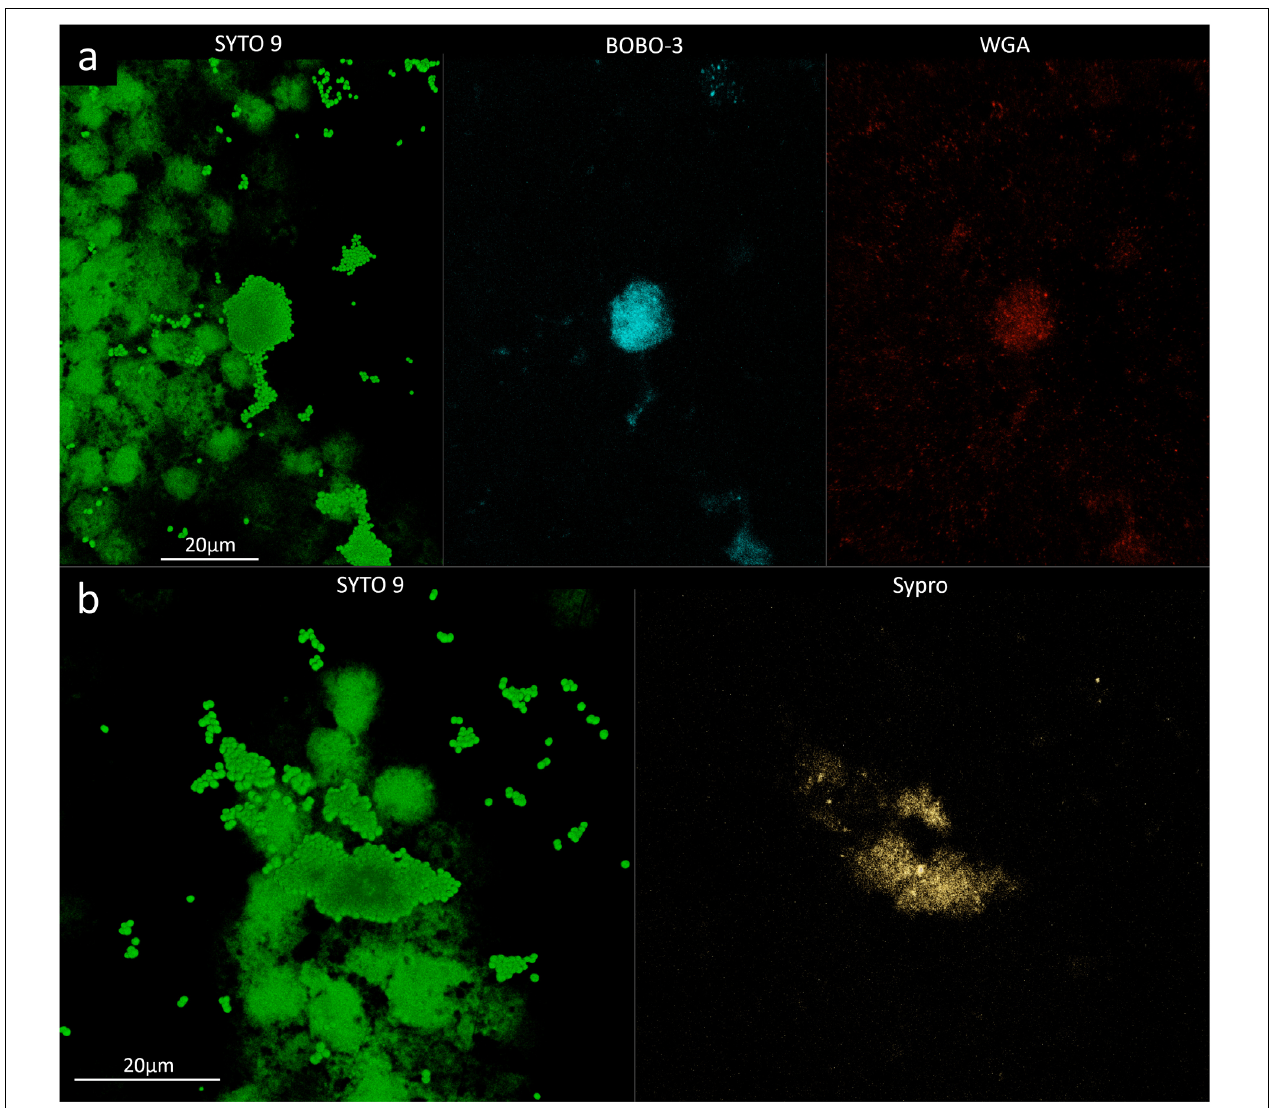
FIGURE 2 | Confocal laser scanning microscopy analysis of synovial fluid infected by Staphylococcus aureus 4. (a) Sample stained with SYTO 9 for cellular biomass (green, left panel), BOBO-3 for eDNA (light blue, central panel), and WGA stain for GlcNAc containing polysaccharides (red, right panel). (b) Sample stained with SYTO 9 for cellular biomass (green, left panel); SYPRO-Ruby staining shows the proteins contained in the biofilm matrix (yellow, right